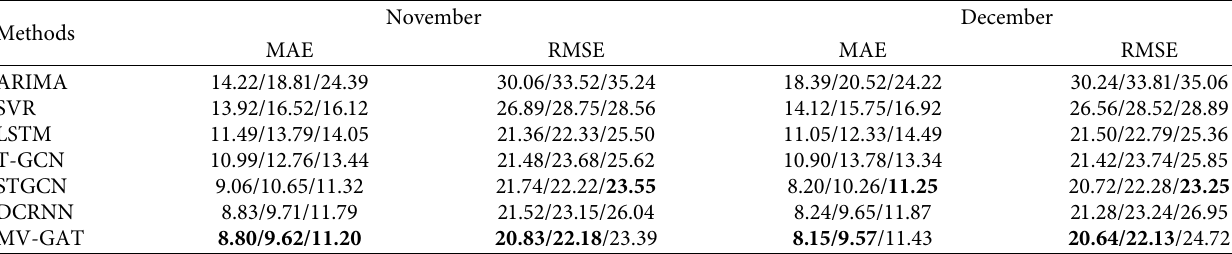
Table 2: Accuracy results of rail passenger flow prediction experiment.